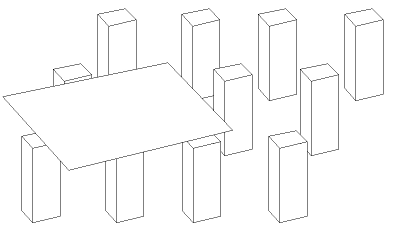
connected to underlying precast reinforced concrete crossbeams